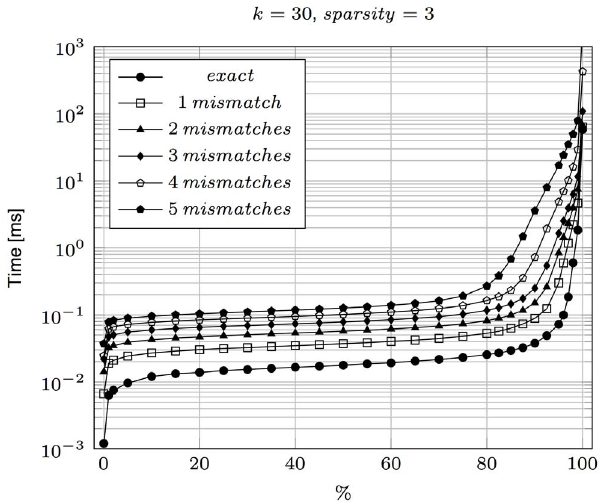
Figure 2. Query time percentiles for exact and approximate matching, for max error up to 5. For example, the 80th percentile for 1 error equal to 0.52 ms means that 80% of the test patterns were handled in time up to 0.52 ms each, allowing for 1 mismatch. Simulated reads were used.